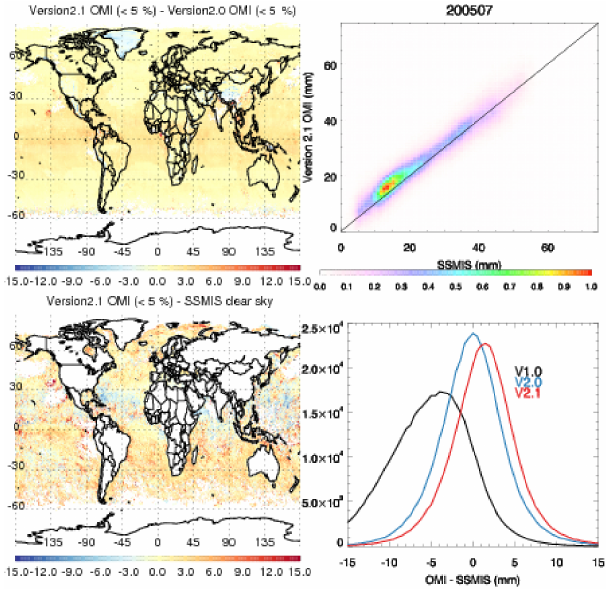
Figure 12. Top left: version 2.1–version 2.0 monthly mean OMI with cloud fraction < 5% for July 2005. The other three pan- els are composed using coincident daily gridded (0.5 ◦ × 0.5 ◦ ) OMI (with cloud fraction < 5%) and “clear” sky SSMIS data for July 2005. Bottom left: monthly mean of version 2.1 OMI − SSMIS. (Top right) 2-D normalized histogram of version 2.1 OMI vs. SSMIS composed using 0.5mm × 0.5mm TCWV bins. Bottom right: histogram of version 1.0 OMI − SSMIS in black, version 2.0 OMI − SSMIS in blue, and version 2.1 OMI − SSMIS in